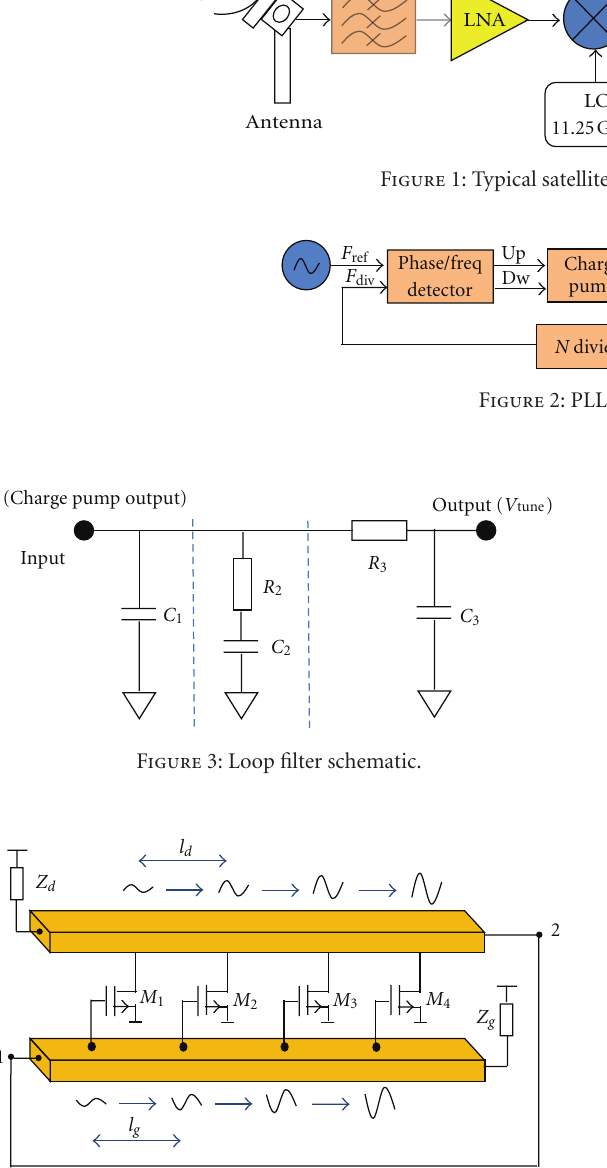
Figure 4: Basic RTW